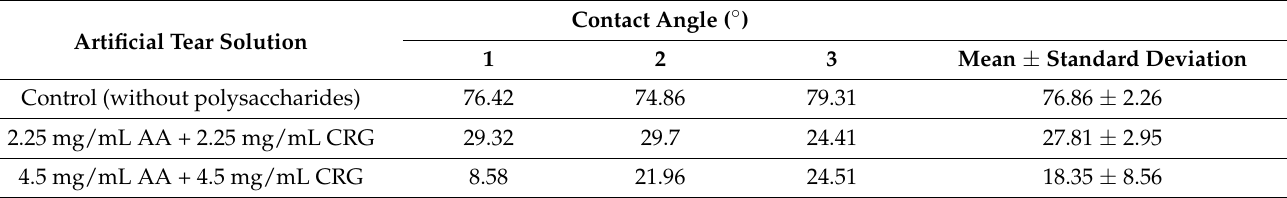
Table 1. Contact angle of each tested lens and averaged contact angle after three cycles of cholesterol and protein adsorption